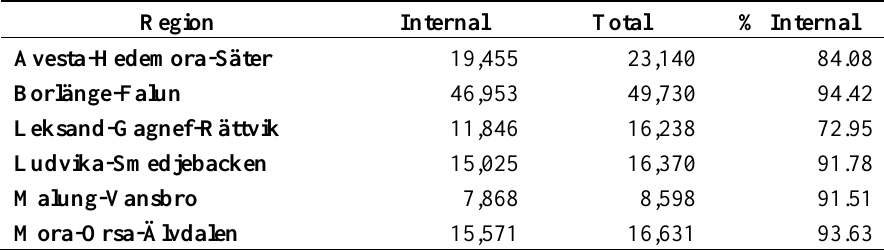
Table 7. Net residence-based self-containment at step 670.